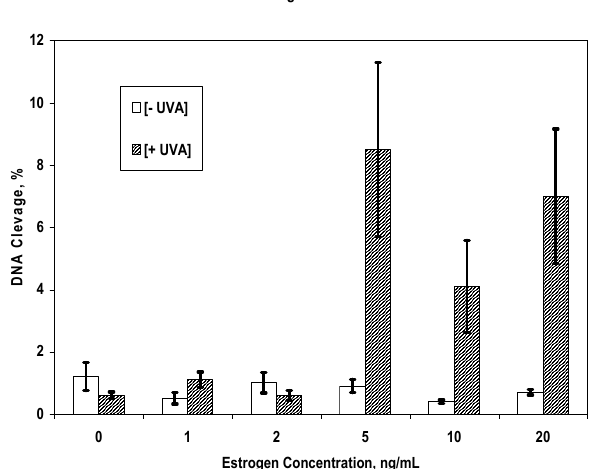
Figure 3: Comparison of Comet assay of Jurkat T cells untreated as controls and cells treated with estrogen at 5 ng/ml ± UVA.